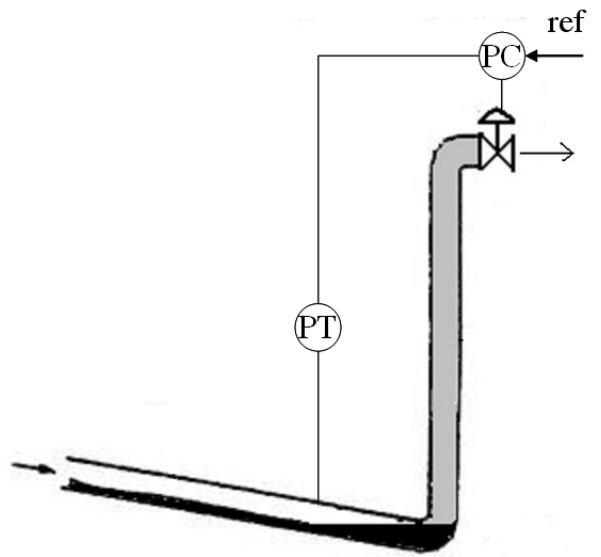
Figure 6: Anti-slug control: Feedback control of pres- sure at bottom of riser.